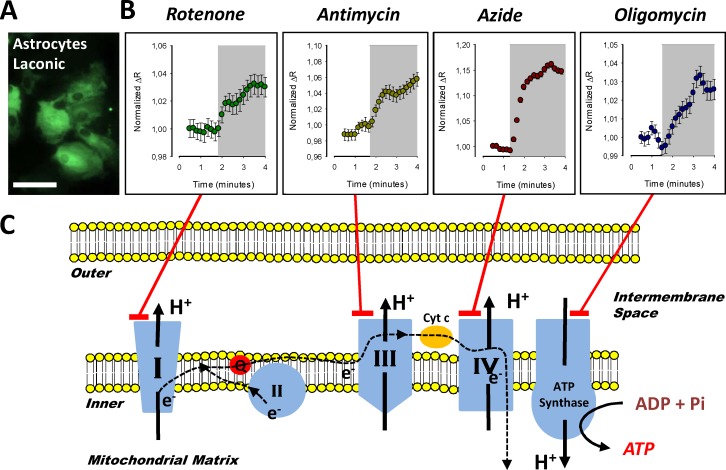
Modulation of astrocytic lactate metabolism by mitochondrial toxicants.A) Primary culture of cortical astrocytes from mice imaged at 440 nm excitation/535 nm emission. B) Cytosolic lactate accumulation induced by treatment with 32 μM rotenone, 16 μM of antimycin, 5 mM azide and 80 μM of oligomycin. Each data point is from an average of ten cells from three independent experiments. C) Schematic representation of molecular targets for each toxicant used in the primary culture of astrocytes.